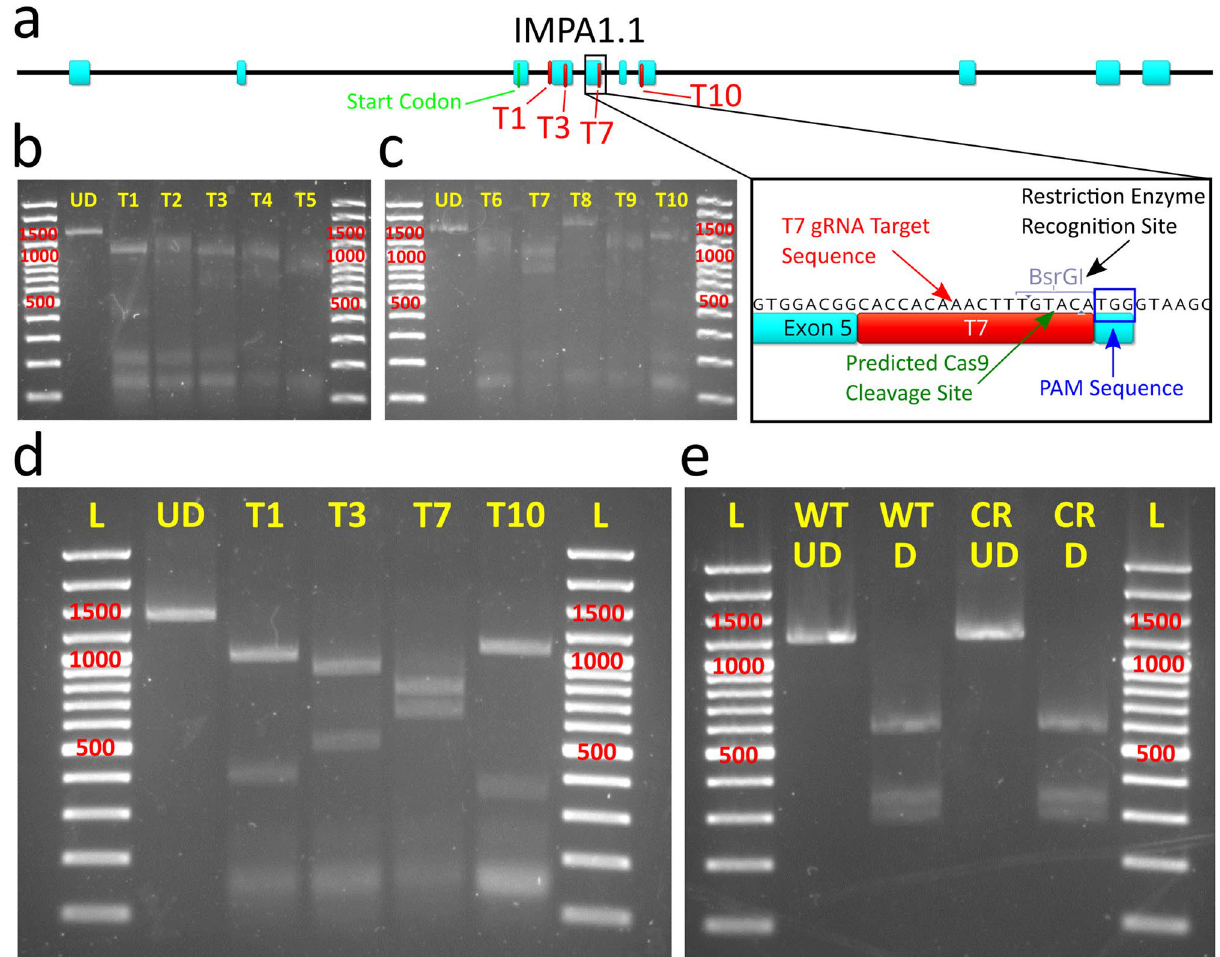
Figure 1. In vitro cleavage assay and OmB cell line gene targeting of IMPA1.1 using Cas9/gRNA RNPs. ( a ) Gene map of Oreochromis IMPA1.1 showing selected gRNA target sites and expanded view of T7 site containing BsrGI restriction site used for analysis of Cas9 cleavage. ( b – e ) Agarose gel images with marker sizes (base pairs or bp) labeled in red ( b and c ) of initial in vitro cleavage assay screen of ten target sites (T1-T10) and reference un-digested substrate amplicon (UD); ( d ) Follow up confirmatory in vitro cleavage assay results of the apparent most efficient cleaving gRNAs from the initial screen showing complete cleavage of substrate amplicon into expected fragments and ( e ) RSM analysis in which the BsrGI digested amplicon from IMPA1.1 T7 CRISPR treated cells (CR D) shows the exact same band pattern as the BsrGI digested wild-type amplicon (WT D) indicating no detectable mutation at the target site. The un-digested amplicons were included for reference (WT UD = wild-type un-digested, CR UD = CRISPR treated un-digested). The gel images in this figure have been significantly cropped to conserve space and increase focus on relevant bands. Full-length gels are presented in Supplementary Figure S1. Gene map and sequence images were generated using Geneious 11.0.3 (Biomatters, https:// www. genei ous. com). Image editing and assembly into complete figures was performed using Inkscape 0.92 (https:// www. inksc ape. the transfected cells persisted and proceeded to proliferate in the selection media indicating stable genomic integration of the transgene. Identification of tilapia U6 promoters that contain vertebrate U6 consensus core ele‑ ments. Because the endogenous OmBAct and OmEF1a promoters were substantially stronger in driving EGFP expression than commonly used heterologous polymerase II promoters, we presumed an endogenous O. mossambicus polymerase III promoter (i.e. U6) would be superior for driving gRNA expression than commonly used human or zebrafish U6 promoters. NCBI Blast searches of known fish U6 genes including promoters and approximately 100 bp of the transcribed region against the NCBI O. niloticus reference genome (taxid: 8128) yielded four unique candidate U6 promoters designated as TU6_1 (LOC112847594), TU6_2 (LOC112846585), TU6_3 (LOC112848092), and TU6_4 (LOC112841904). TU6_1, found by BLAST of a medaka U6 (taxid: 8090, LOC111948268), contained a well-defined TATA box at position − 31 to − 23 from the transcription start site (TSS + 1) (Fig. 3a). Moreover, sequence alignments of the four candidate tilapia U6 promoters against each other